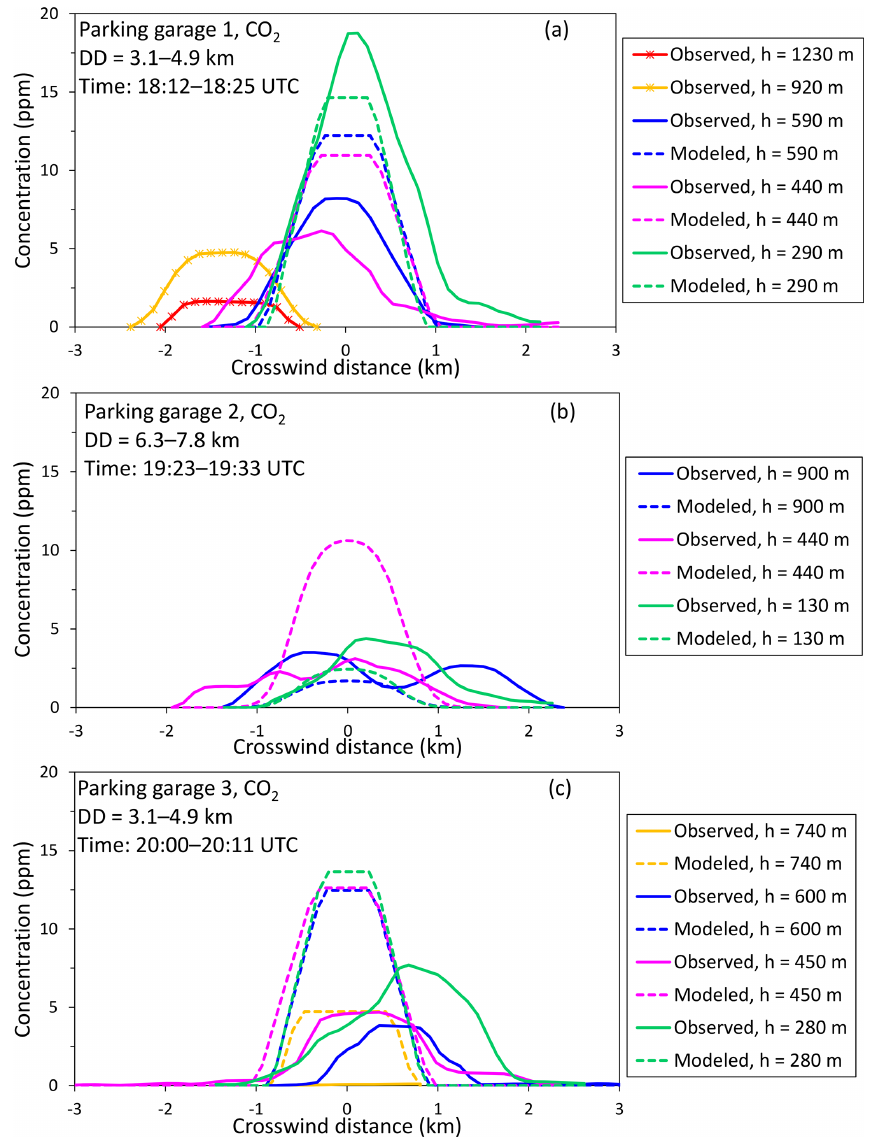
Figure 6. Observed (solid lines) and modeled (dashed lines) horizontal distributions of the excess concentrations of CO 2 for three parking garage flight maneuvers. The corresponding measured and modeled curves are presented with the same color. Notation: DD – downwind distance from the center of the L2F burn block, time – the time interval of the maneuver of the measurement aircraft, h – the elevation above ground, UTC – Coordinated Universal